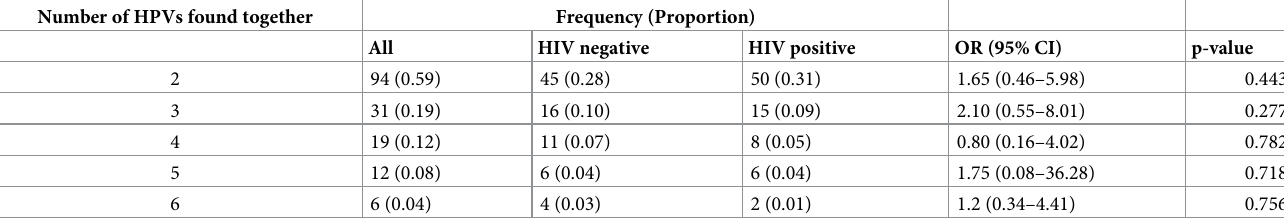
The prevalence of the various HPV genotypes in the Zimbabwean study cohort was compared to the most common HPV genotypes on other African women across the continent, using data obtained from HPV Information Centre database [47] and summarized into Table 4. In comparison to the rest of the African continent data, our study reported significantly higher HPV35 (p < 0.001), HPV51 (p = 0.043), HPV58 (p = 0.010) and HPV39 (p = 0.043). Across the different African regions, most of the HPV genotypes were comparable (p > 0.05), and HPV16 was the most prevalent genotype. However, in North Africa (p = 0.047), the frequency of HPV16 is significantly higher, while HPV45 (p = 0.011) and HPV59 (p = 0.005) are signifi- cantly higher in West Africa compared to the other African regions. Additionally, the HPV information centre database also showed that HPV26 was one of the top 10 genotypes detected in cervical cancer tissue in Southerrn Africa, and HPV53 in Northern and Southern Africa. Table 3. Multiple HR-HPV infections, stratified by HIV status (n = 163). Number of HPVs found